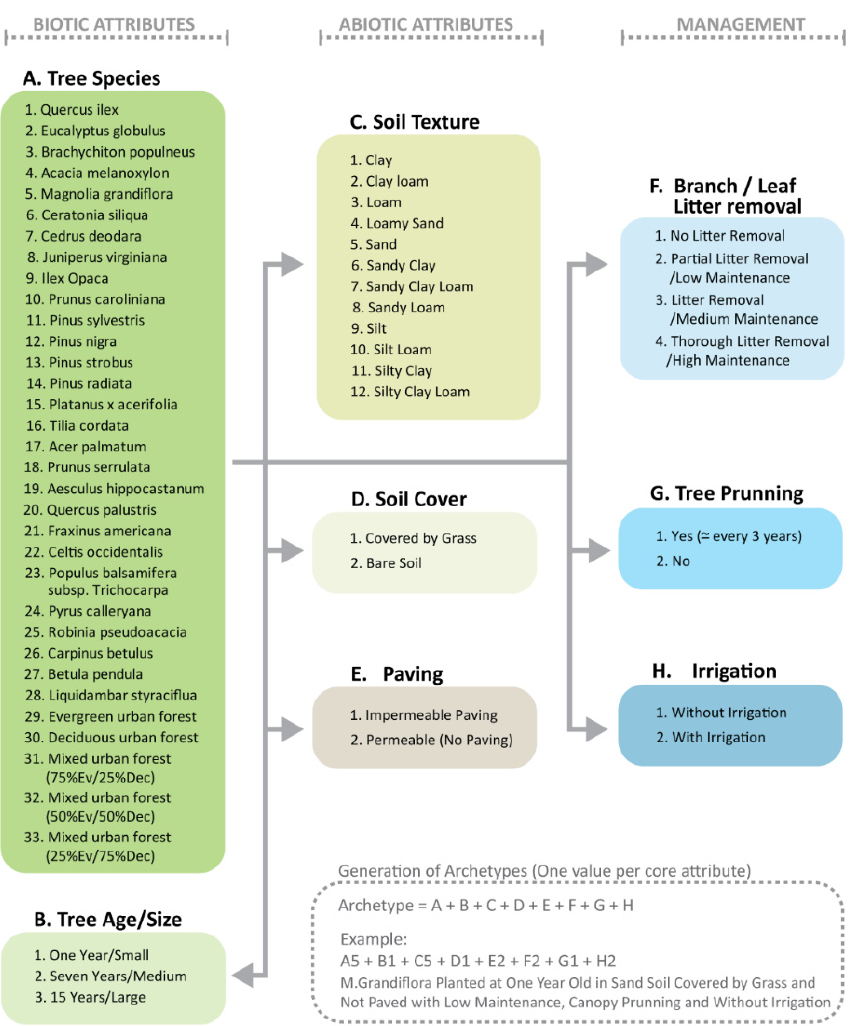
Figure 4. Biotic, abiotic, and management attributes that define urban forest archetypes in the system dynamics model underneath NBenefit$.